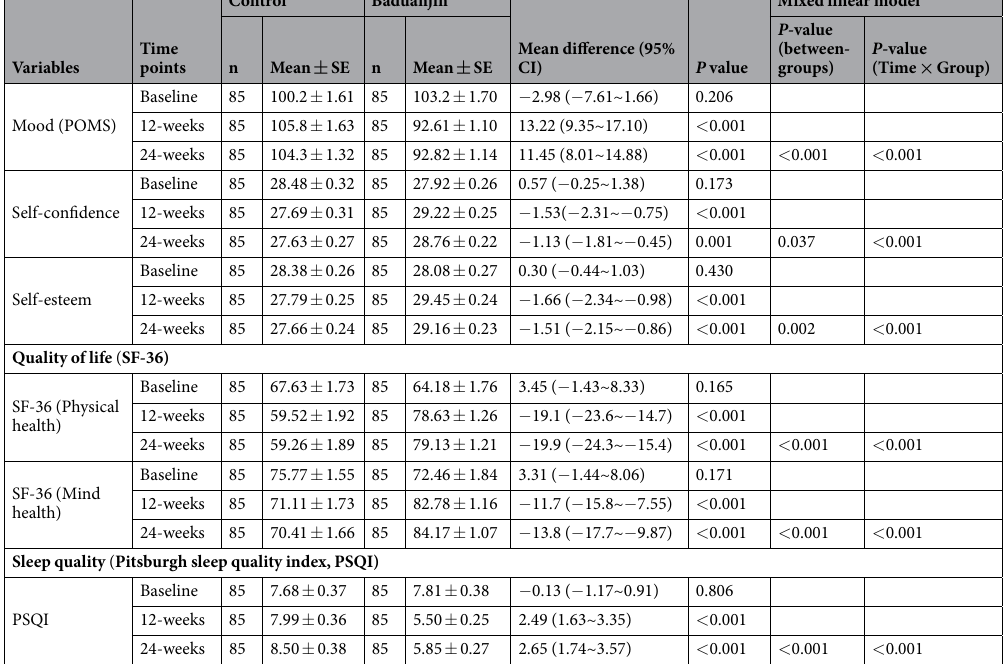
Table 6. The related psychological outcomes at all time